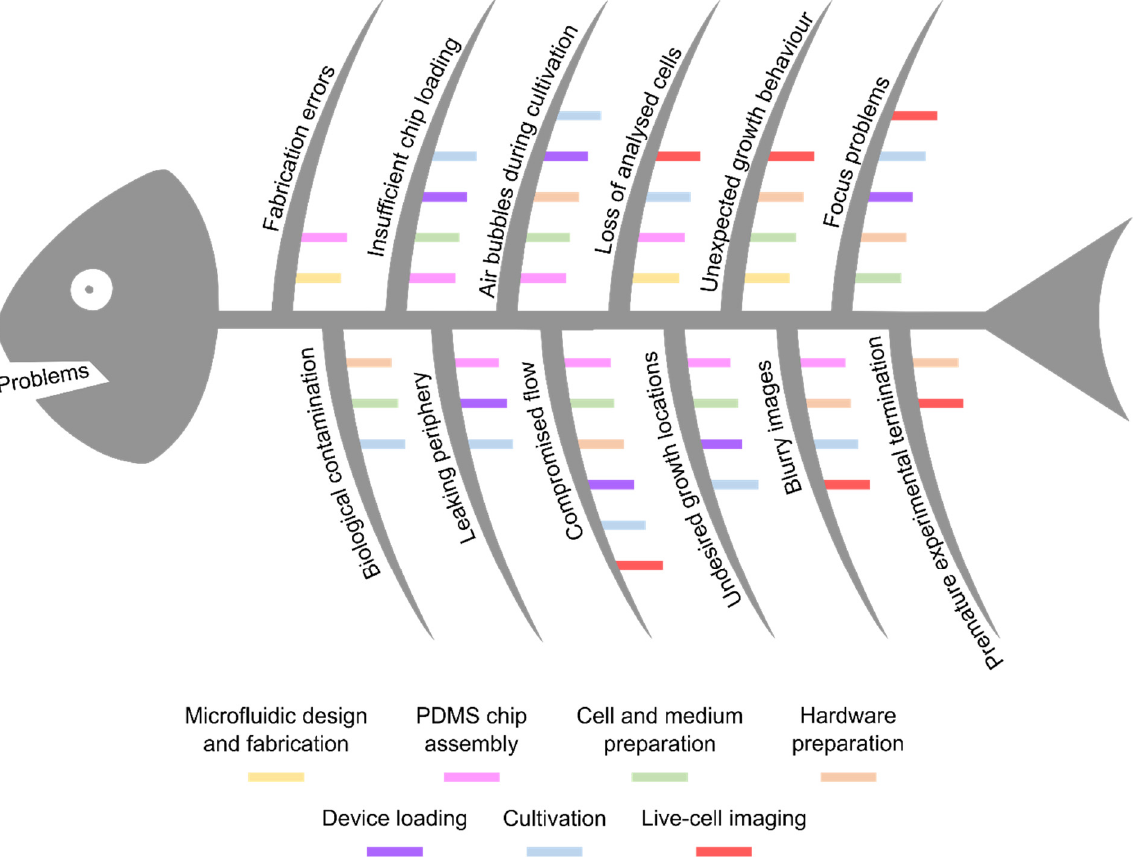
Figure 3. Fishbone diagram of the most frequent challenges during MC. The challenges are arranged according to their temporal order along the workflow of an experiment. Small, coloured fishbones indicate the experimental step in which these challenges most probably have their origin. The introduced colour code matches the colouring of the previous workflow diagram (Figure 2).